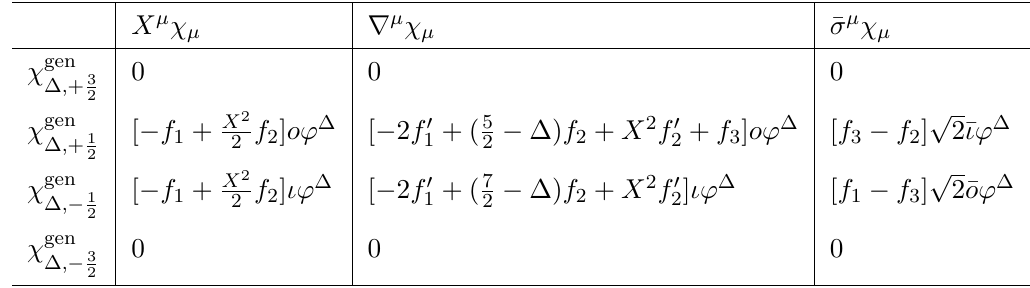
Table 7. Various constraints one can impose on a generalized conformal primary gravitino. There are two such solutions, a G and M mode, at each of these (∆ , J ) . For (2.32) the two solutions for fixed ∆ are radiative spin-1 conformal primary wavefunctions (2.11) and their shadows (2.14). The G and M wavefunctions for (2.33) will correspond to primary descendants at the bottom corner of the celestial photon diamonds discussed in section